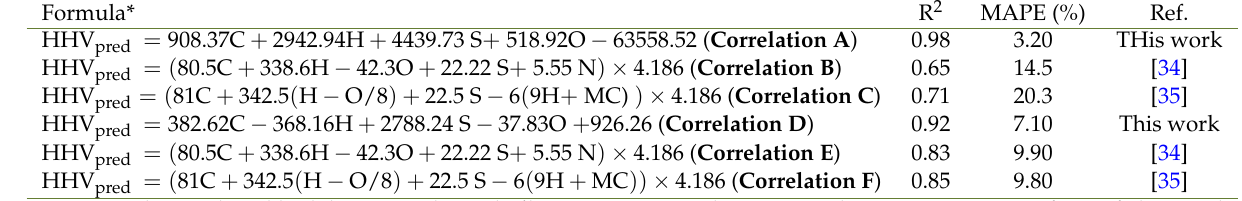
Table 1. Correlations for predicting the calorific value of MSW, biomass, and biochar. Formula* R 2 MAPE (%) Ref.